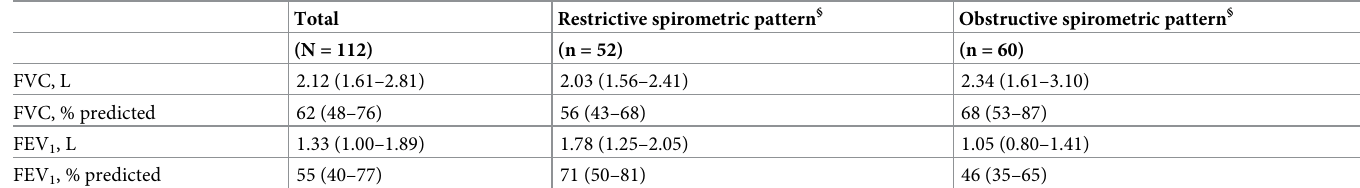
Table 2. Pulmonary function